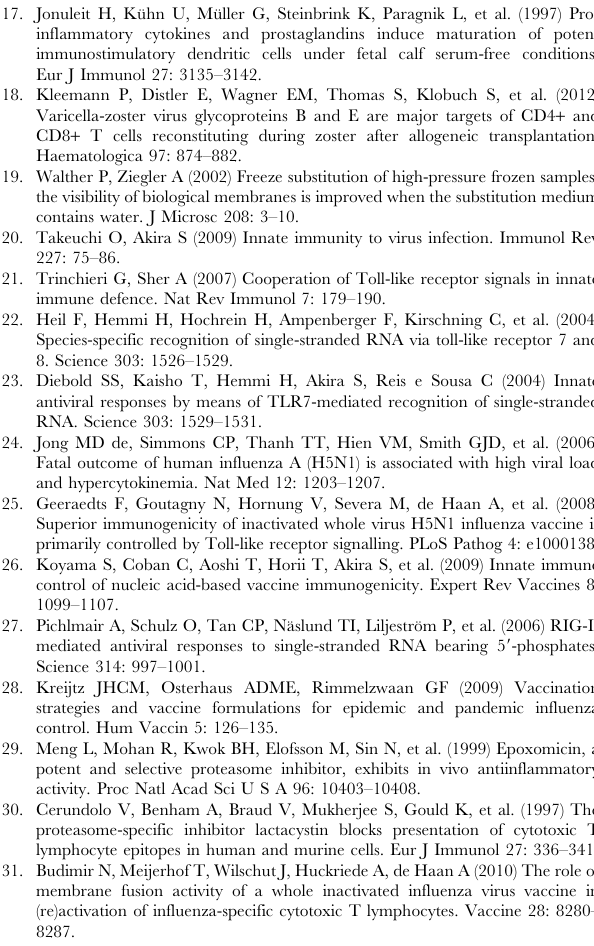
with 1 6 10 5 CD4 + T cells (grey columns) or 1 6 10 5 CD8 + T cells (black columns) plated per well are shown. Figure S3 Protein composition, RNA content, and physical structure of whole virus and split virus vaccines. Shown data are from vaccine formulations of seasonal strain B/Brisbane (BB). (A) Semiquantitative SDS-PAGE analysis indicated similar distribution and concentration of proteins in split virus (s) and whole virus (w) preparations. (B) Electropherograms showed clearly different size distribution of RNA from split virus versus whole virus preparations. RNA of split virus preparation was considerably more degraded and of much smaller size. Split virus and whole virus preparations contained 7 pg and 627 pg RNA per m L per dose (500 m L), respectively (not shown). (C) TEM analysis of vaccine samples using a FEI Tecnai 10 microscope operated at 100 kV. Pictures were taken with an Olympus Veleta camera. The size scale is indicated. FU, fluorescence units; nt, nucleotides; kDa, kiloDalton. Figure S4 Confocal LSM analysis of DC loaded with whole and split virus vaccines. Immature DC were analyzed after 4 h incubation with seasonal A/H3N2-Uruguay whole virus vaccine (URw), its corresponding split virus vaccine (URs), or PBS as negative control. The nucleus (Hoechst 33342) is stained in blue color, whereas endolysosomal compartments (Lamp1/Rab5) are